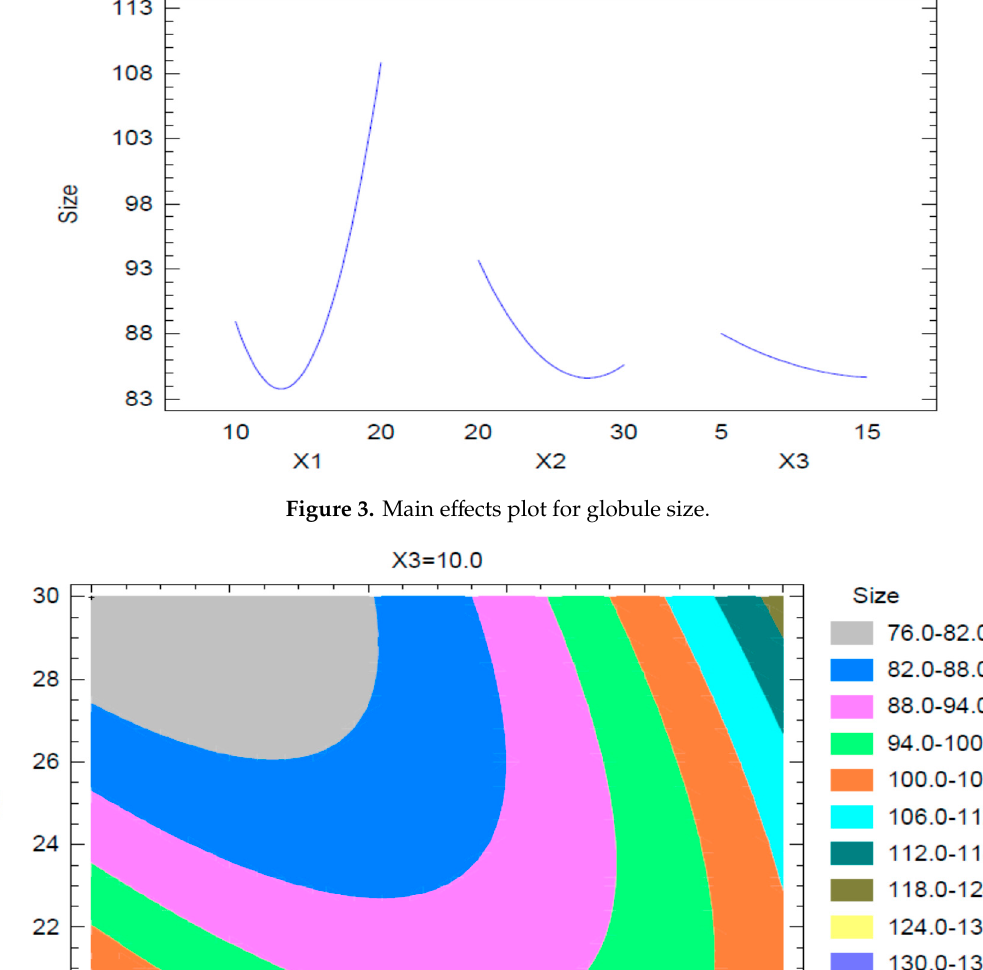
Figure 4. Contour plot for globule size. Table 4. Optimized nanoemulsion formula and predicted